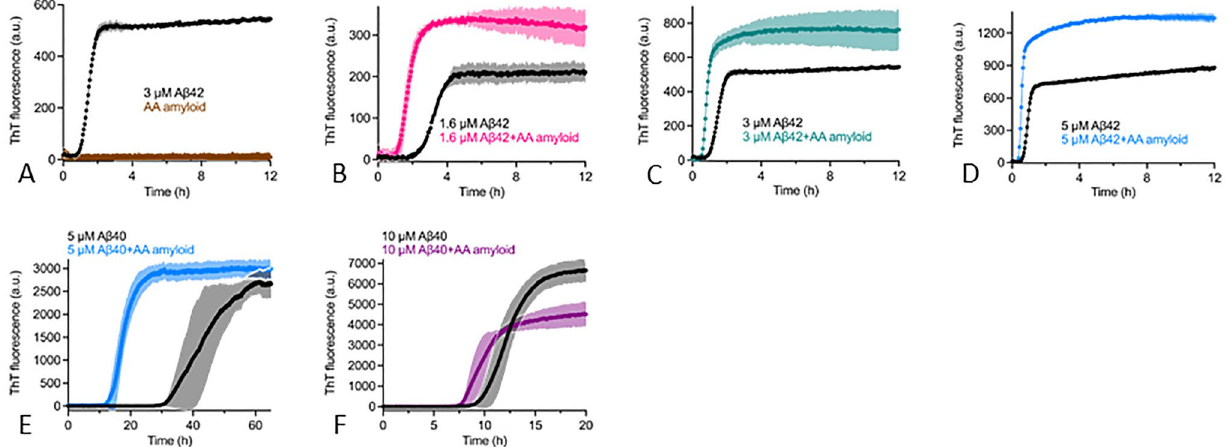
Figure 3. ( A – D ). AA amyloid from cattle cross seeds human Aβ42 in vitro. ( A ) 3 µM recombinant Aβ42 and AA amyloid isolated from a bovine kidney (400 × dilution from the stock as final concentration) were monitored separately in the presence of ThT at 37 °C. Aggregation traces of different concentrations of Aβ42, i.e., 1.6 µM ( B ), 3 µM ( C ) and 5 µM ( D ) with and without bovine AA amyloid (400 × dilution from the stock as final concentration) at 37 °C. The data is presented as mean with error bars (SD from four replicates). ( E , F ) AA amyloid fibrils from cattle cross seed human Aβ40 in vitro. Aggregation traces of different concentrations of Aβ40, i.e., 5 µM ( E ) and 10 µM ( F ) with and without AA amyloid (400 × dilution from the stock as final concentration) at 37 °C. The data is presented as mean with error bars (SD from four